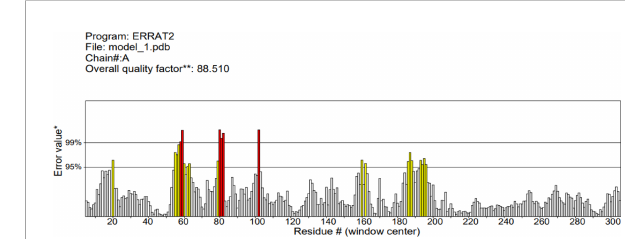
FIGURE 3 ERRAT diagram depicting the quality of the modeled structure of VACCINE. *On the error axis, two lines are drawn to indicate the con fi dence with which it is possible to reject regions that exceed that error value.**Expressed as the percentage of the protein for which the calculated error value falls below the 95% rejection limit. Good high resolution structures generally produce values around 95% or higher. For lower resolutions (2.5 to 3A) the average overall quality factor is around 91%. #residue refers to a single unit that makes up a polymer, such as an amino acid in a polypeptide or